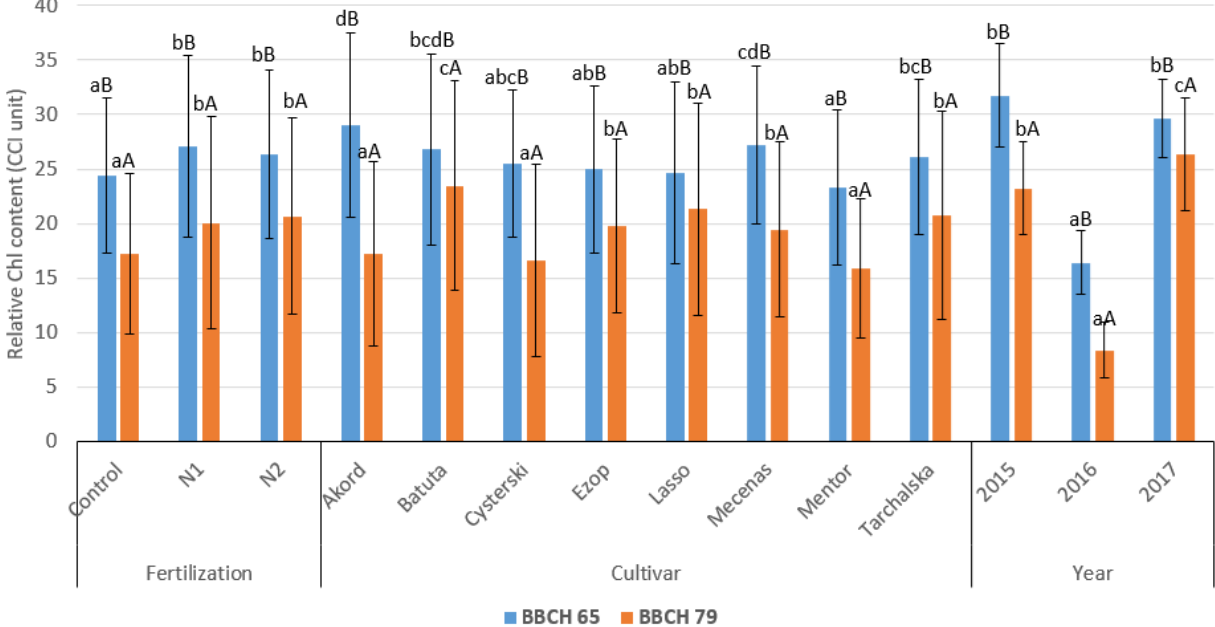
Figure 2. Relative Chl content in pea bracts under the interaction of years and foliar fertilization. N1—fertilizers/biostimulators of plant origin, N2—biostimulants of animal origin. Error bars are stand- ard deviations of the means. Different letters above the columns indicate significant difference be- tween treatments: small letters for fertilization and capital letters for measurement terms (ANOVA, Tukey test) at p < 0.05.